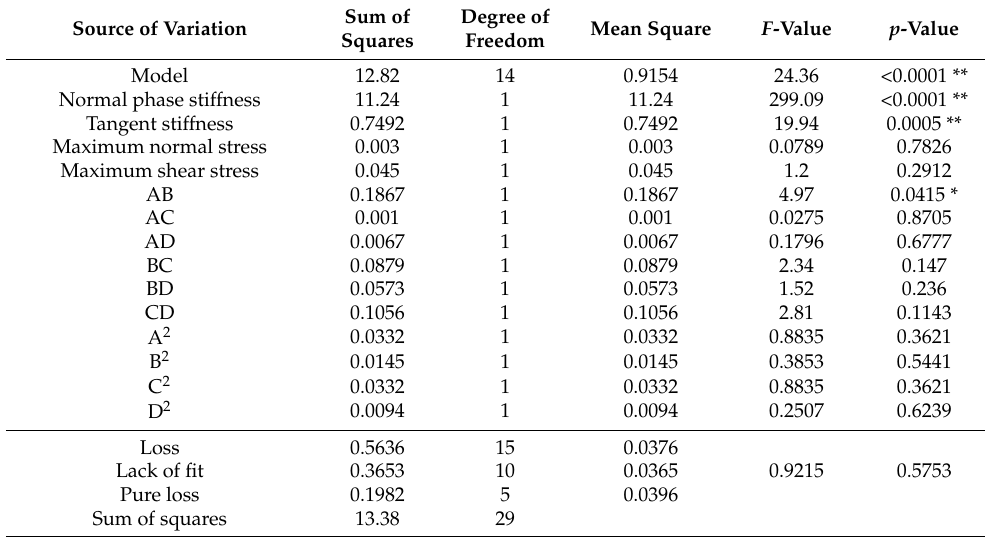
Table 10. Quadratic full model analysis of variance on the response surface of bending